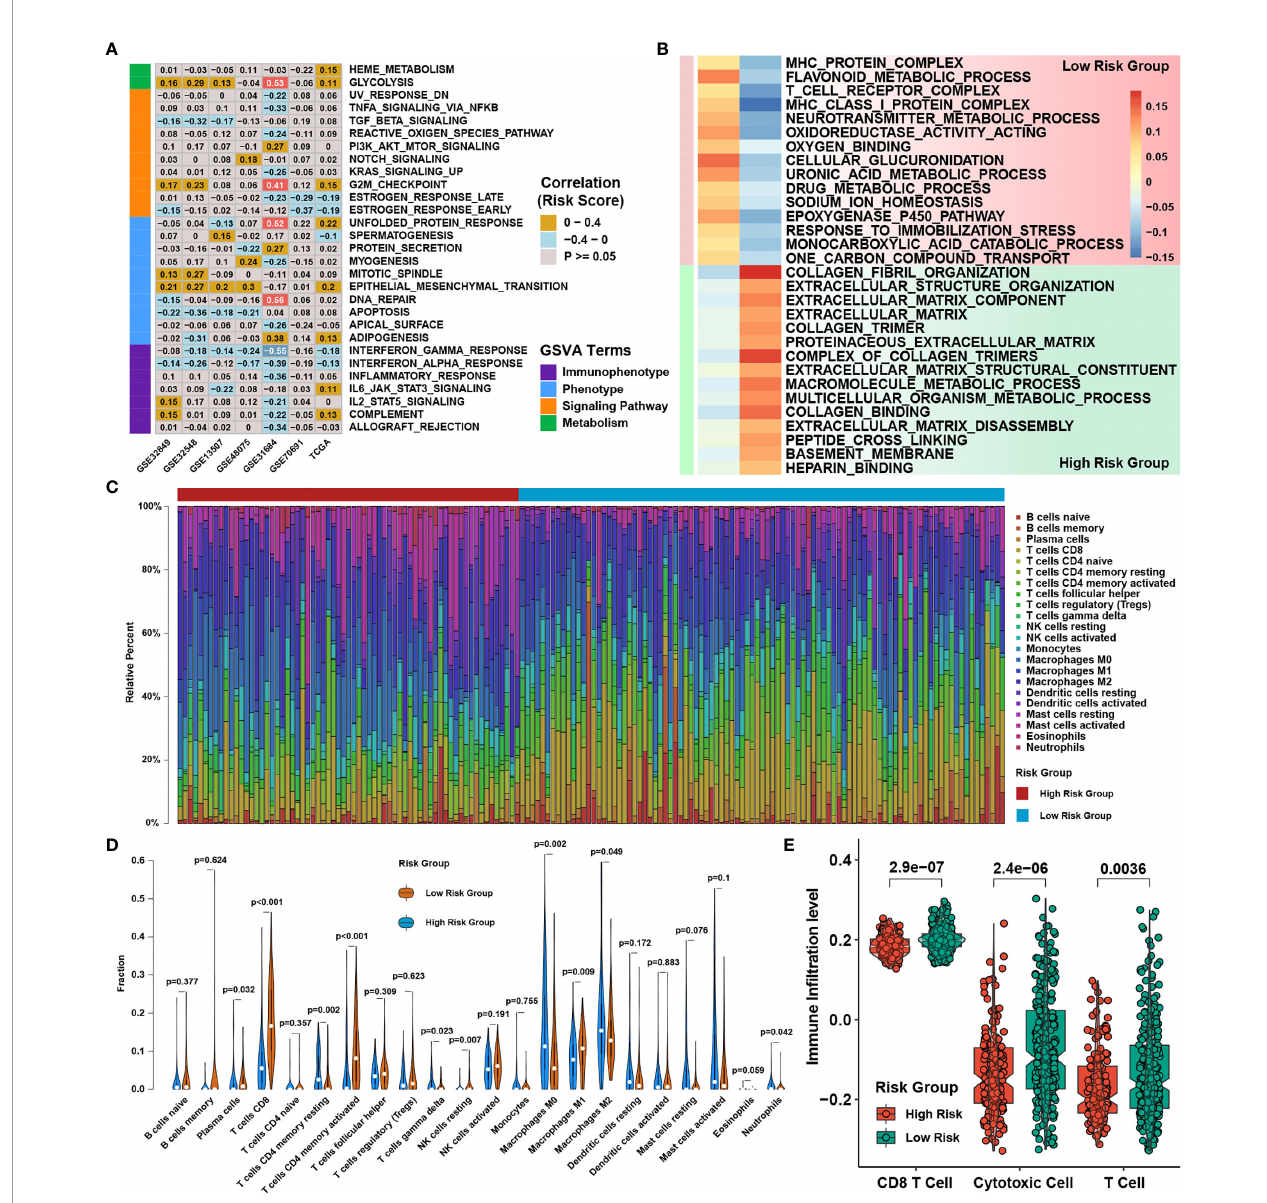
FIGURE 5 | Functional characteristics of the writer-related gene signature. (A) Correlation analysis between the GSVA score for curated pathways and risk score in seven independent datasets. (B) GSEA revealed distinct enriched gene sets between risk score groups. In the heatmap, rows represent the 30 selected gene sets, and columns represent the consensus scores for each group. (C) The distribution of 22 immune cells calculated by CIBERSORT in the TCGA BLCA cohort. (D) Violin plot of the relative in fi ltration level of immune cells in the TCGA BLCA cohort. (E) The abundance of CD8 T cells, cytotoxic cells and T cells assessed by ssGSEA in different risk